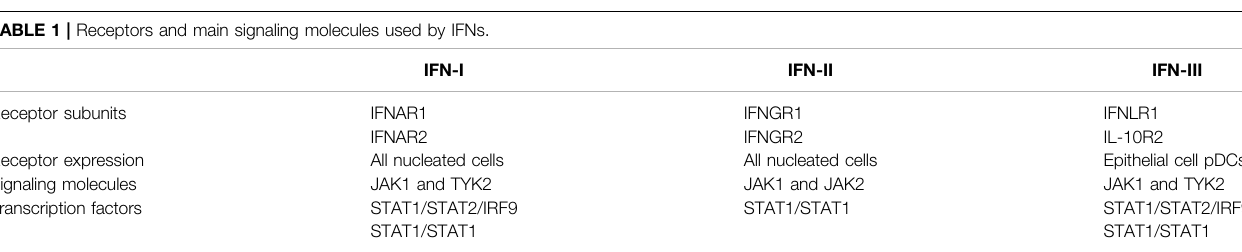
TABLE 1 | Receptors and main signaling molecules used by